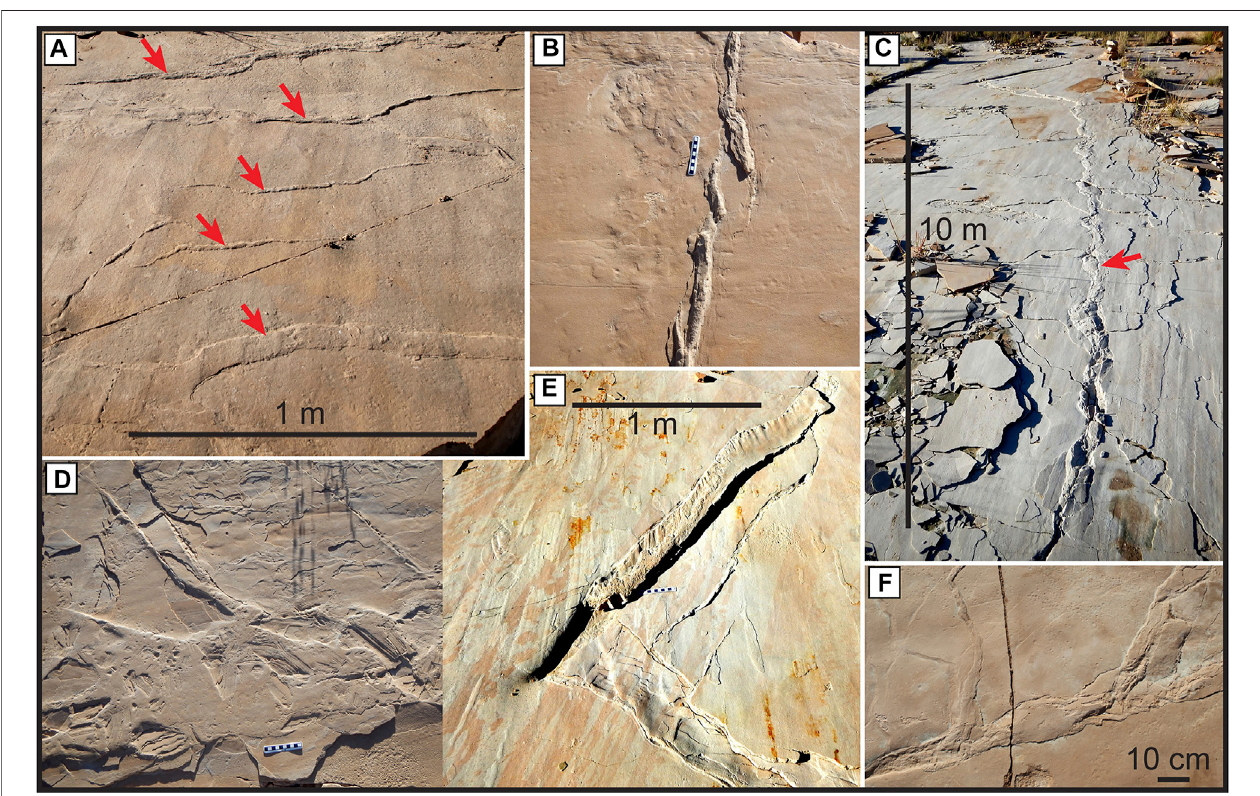
FIGURE 3 | Surface view of representative SSDSs on cross-bed surfaces. (A) This structure contains fi ve parallel folds or ridges, marked by arrows. (B) A single ridge, broken into several en echelon sections, with afeatureless disturbance along the left side of the ridge. (C) A fold that is more than 10 m long, marked by an arrow. (D – F) Small sections of complex folds. The structure in (D) is wider than most, and includes several rotated blocks. Cross-beds dip toward the bottom of each photo. Scale bars in (B,D) are 10 cm